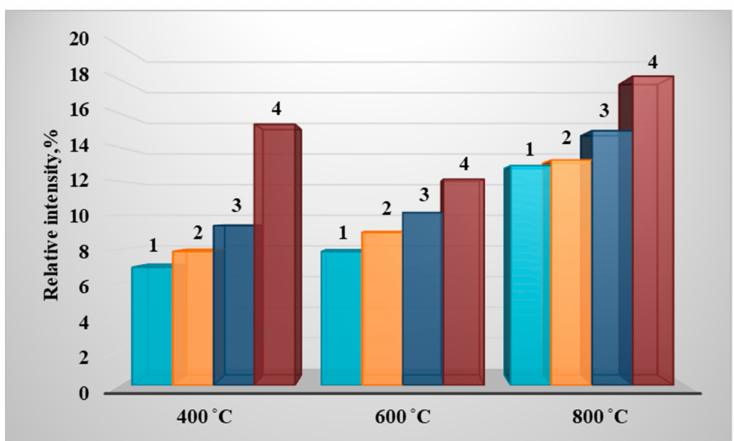
Figure 10. Change in the content of calcium sulfate in pyrolysis products of lean coal of grade T, wood and a mixture of this coal with wood (with an increase in the mass of wood in the mixture) during pyrolysis in the absence of oxygen of fuel samples weighing up to 15 g in the temperature range from 400 ◦ C to 800 ◦ C: 1. Coal T_100%; 2. Coal T_90%/Wood_10%; 3. Coal T_75%/Wood_25%; 4. Coal T_50%/Wood_50% [36].